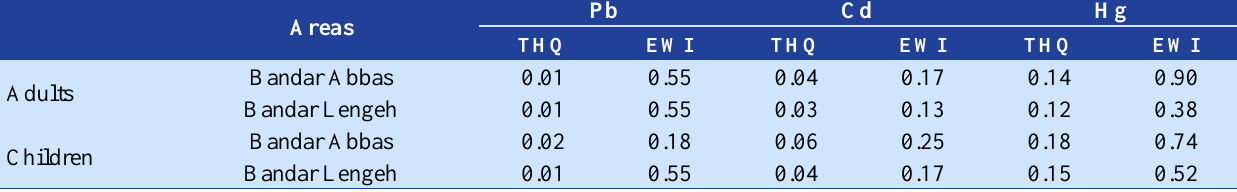
Table 6. THQs and EWI for individual metals caused by the consumption of fish